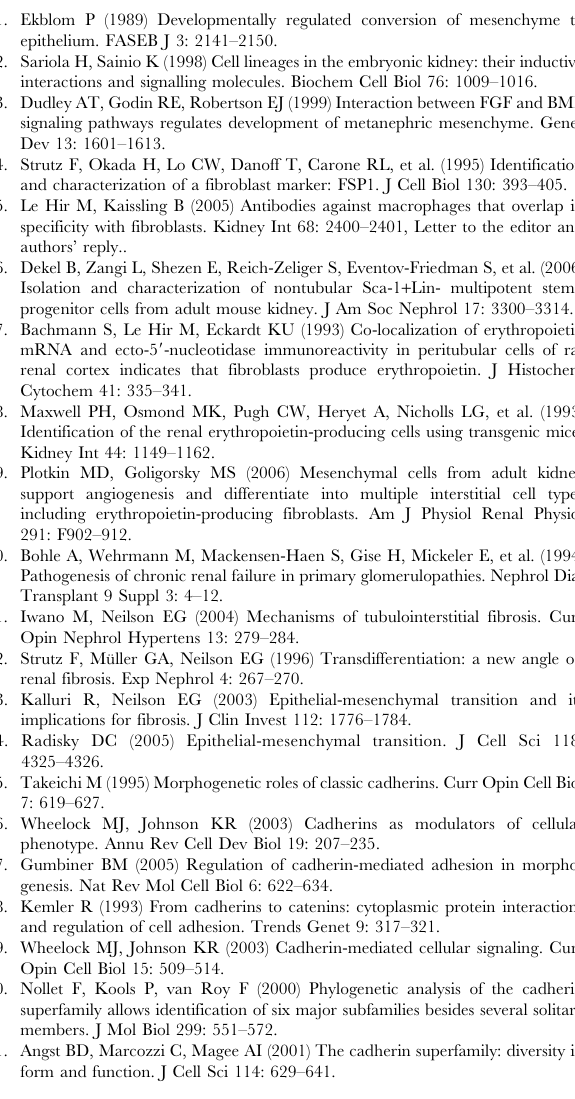
Figure S2 Cadherin-9 knockdown impairs the ability of renal fibroblasts to aggregate Phase contrast pictures of TK 188 cells treated with cadherin-9 or control siRNA were taken before (0 min) and after 20 min of aggregation. At t =0 most cells were single cells or very small aggregates (upper row). After 20 min the cadherin-9 siRNA treated cells formed more and smaller aggregates (lower left) compared to the control cells (lower right), showing that the ability of renal fibroblasts to aggregate was impaired by the knockdown of cadherin-9. Figure S3 Cadherin-9 is not expressed by human skin fibroblasts Immunohistochemical staining of cadherin-9 in human skin cryostat sections revealed no specific staining of any cells compared to the negative control, in which the primary antibody was omitted. Bars represent 50 m m. (B) The primary human skin fibroblasts SK 173 were analyzed for cadherin-9 expression